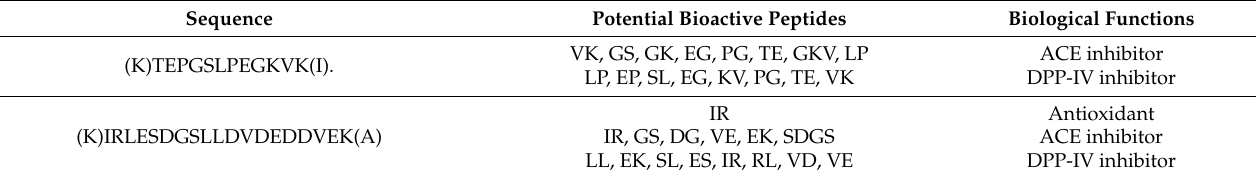
Table 1. Potential bioactivities according to BIOPEP database